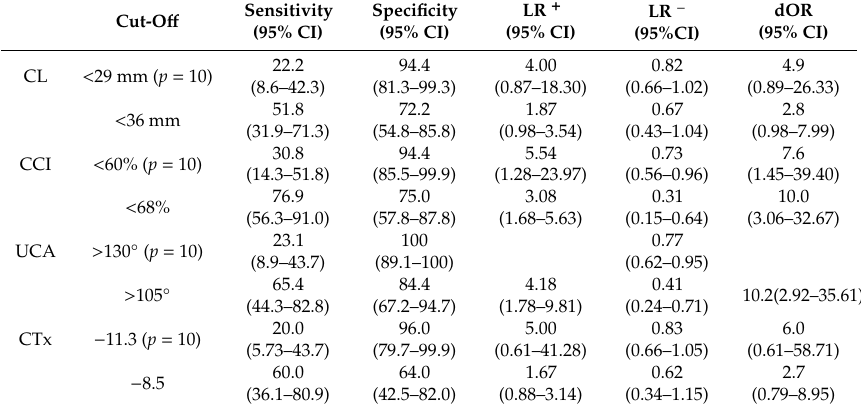
Table 3. Discriminative performance of the CL, CCI, UCA, and CTx measurements with regard to predicting spontaneous preterm birth < 37 + 0 weeks, with optimal cut-o ff based on the receiver operating characteristic curve